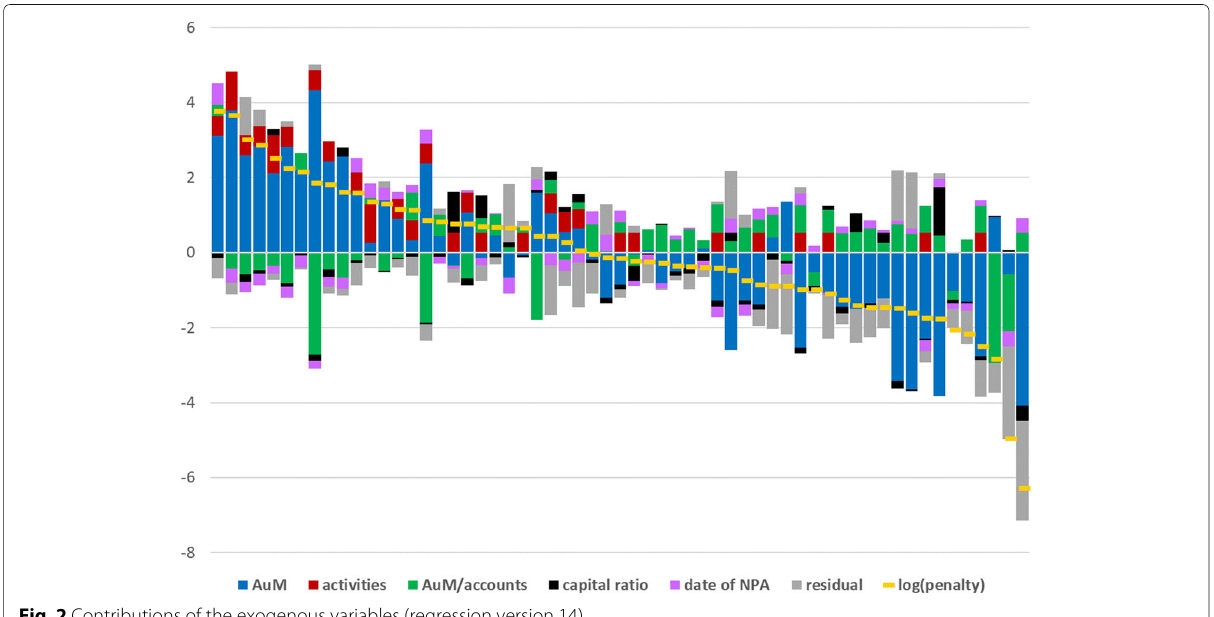
Fig. 2 Contributions of the exogenous variables (regression version 14)